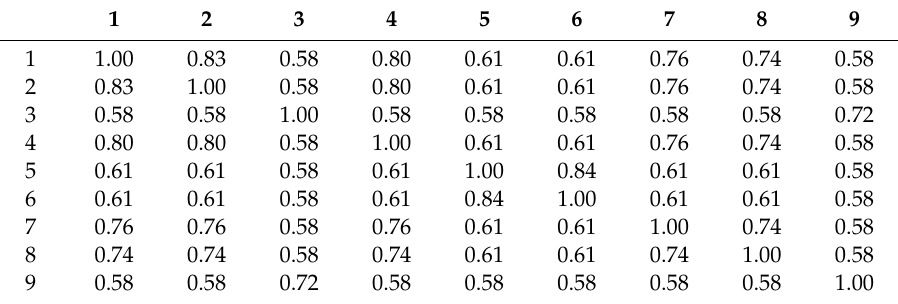
Table 9. Fuzzy equivalence matrix.